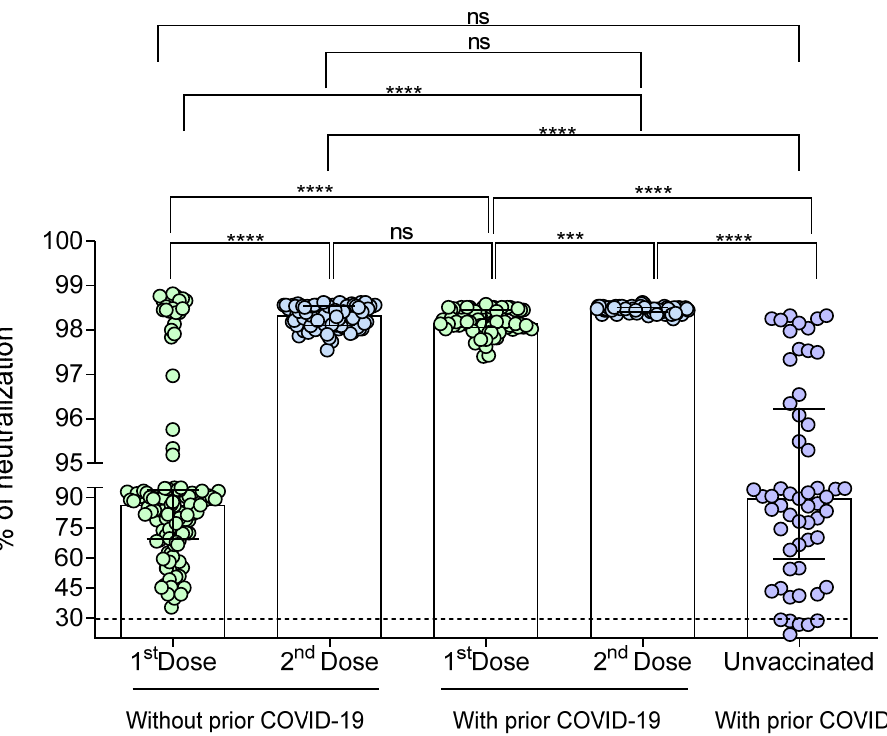
Figure 5. Comparison of the neutralization percentages of the antibodies generated in response to the BNT162b2 vaccine or single SARS-CoV-2 infection. The difference between all groups was calculated with the Kruskal–Wallis test, followed by Dunn’s multiple comparison test. The data are provided as medians and interquartile ranges. ***, p < 0.001; ****, p < 0.0001; ns, not significant ( p > 0.05). Outliers were removed for data